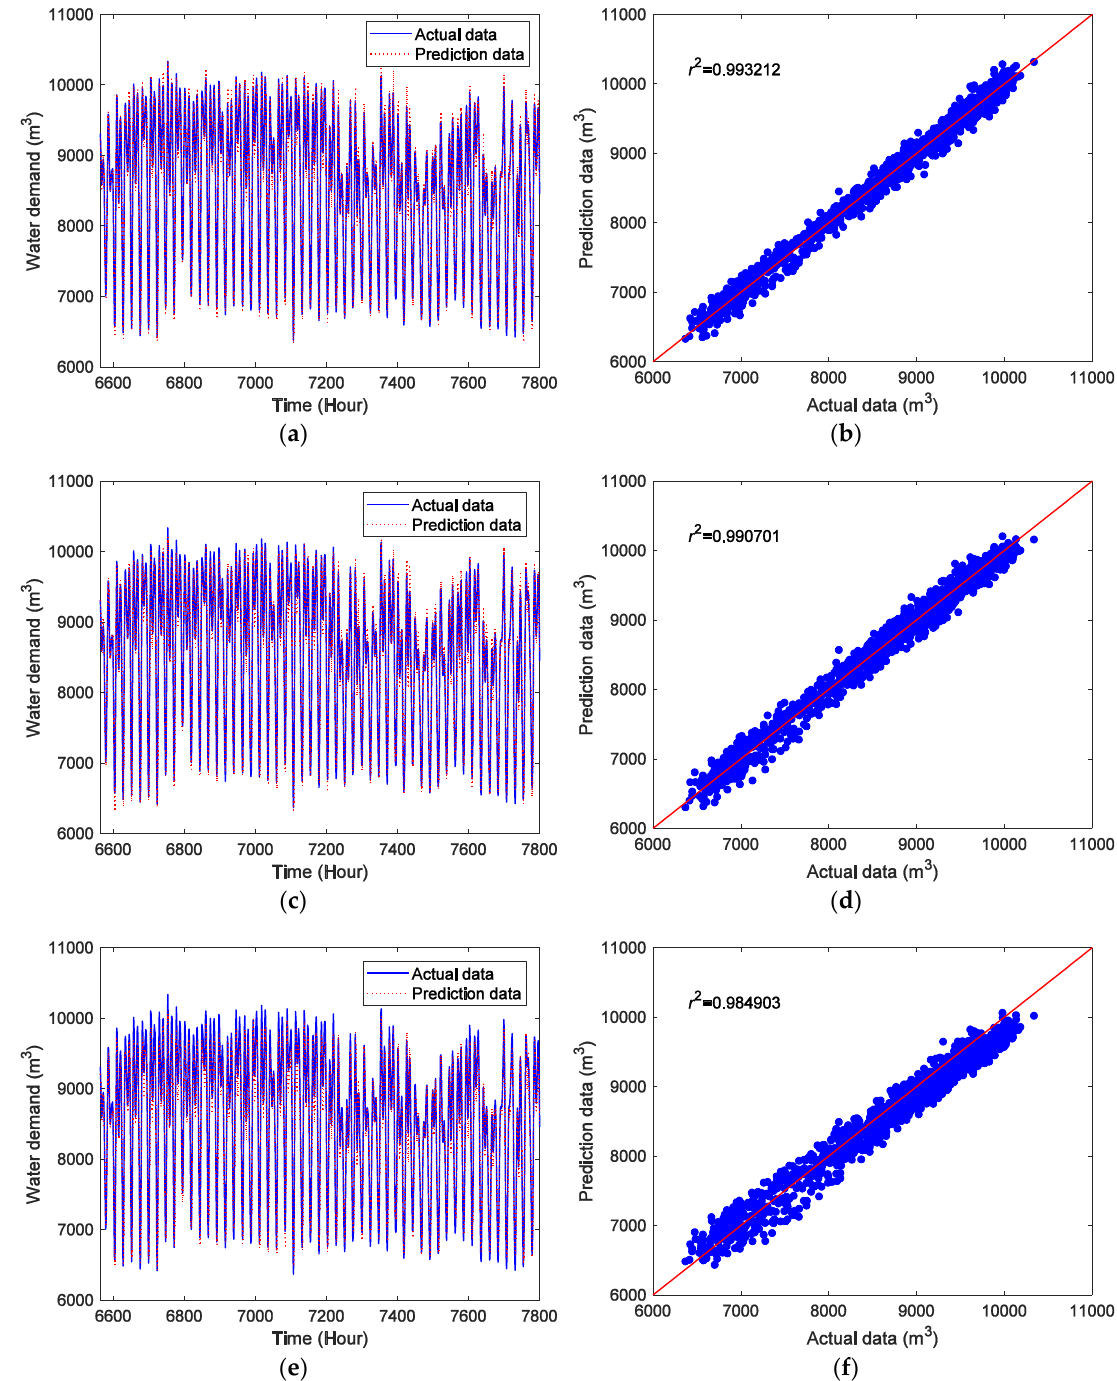
Figure 7. Prediction results and scatter plots of the hourly water demand in the testing stage using different models: ( a ) and ( b ) for ESN, ( c ) and ( d ) for CDBNN, and ( e ) and ( f ) for SVR.